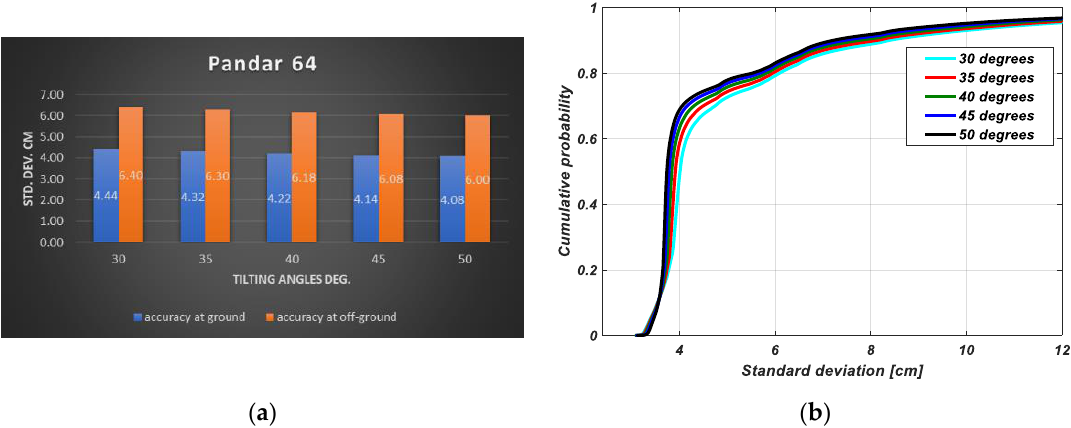
Figure 16. ( a ) Histogram illustrating the achieved relative accuracy using Pandar64. ( b ) CDF accuracy chart. The CDF chart shows the accuracy of the point cloud at each tilting angle using Equation